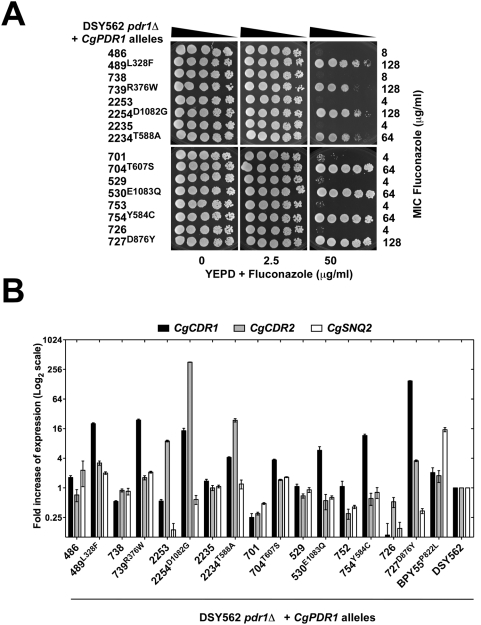
Reconstitution of CgPDR1 GOF alleles in C. glabrata.(A) Fluconazole susceptibility testing of DSY562 pdr1Δ mutant strain (SFY93) expressing different CgPDR1 alleles, which were named according to their strain number origin and by indicating the amino acid substitution (in superscript) associated with a specific strain number. The following strains correspond to the indicated genotypes: DSY562 pdr1Δ+486:SFY98; 489L328F: SFY99; 738: SFY100; 739R376W: SFY101; 2253: SFY102; 2254D1082G:SFY103; 2235: SFY104; 2234T588A: SFY105; 701: SFY106; 704T607S: SFY107; 529:SFY108; 530E1083Q: SFY109; 753: SFY110; 754Y584C: SFY111; 726: SFY112; 727D876Y: SFY113; BPY55P882L: SFY116. (B) Expression of CgCDR1, CgCDR2, and CgSNQ2 in the DSY562 pdr1Δ mutant strain (SFY93) expressing different CgPDR1 alleles, named according to their strain number origin. Quantification was performed by real-time RT-PCR. The values, which are averages of four separated experiments, represent the increase in gene expression relative to DSY562 (set at 1.00). Error bars show standard deviations.